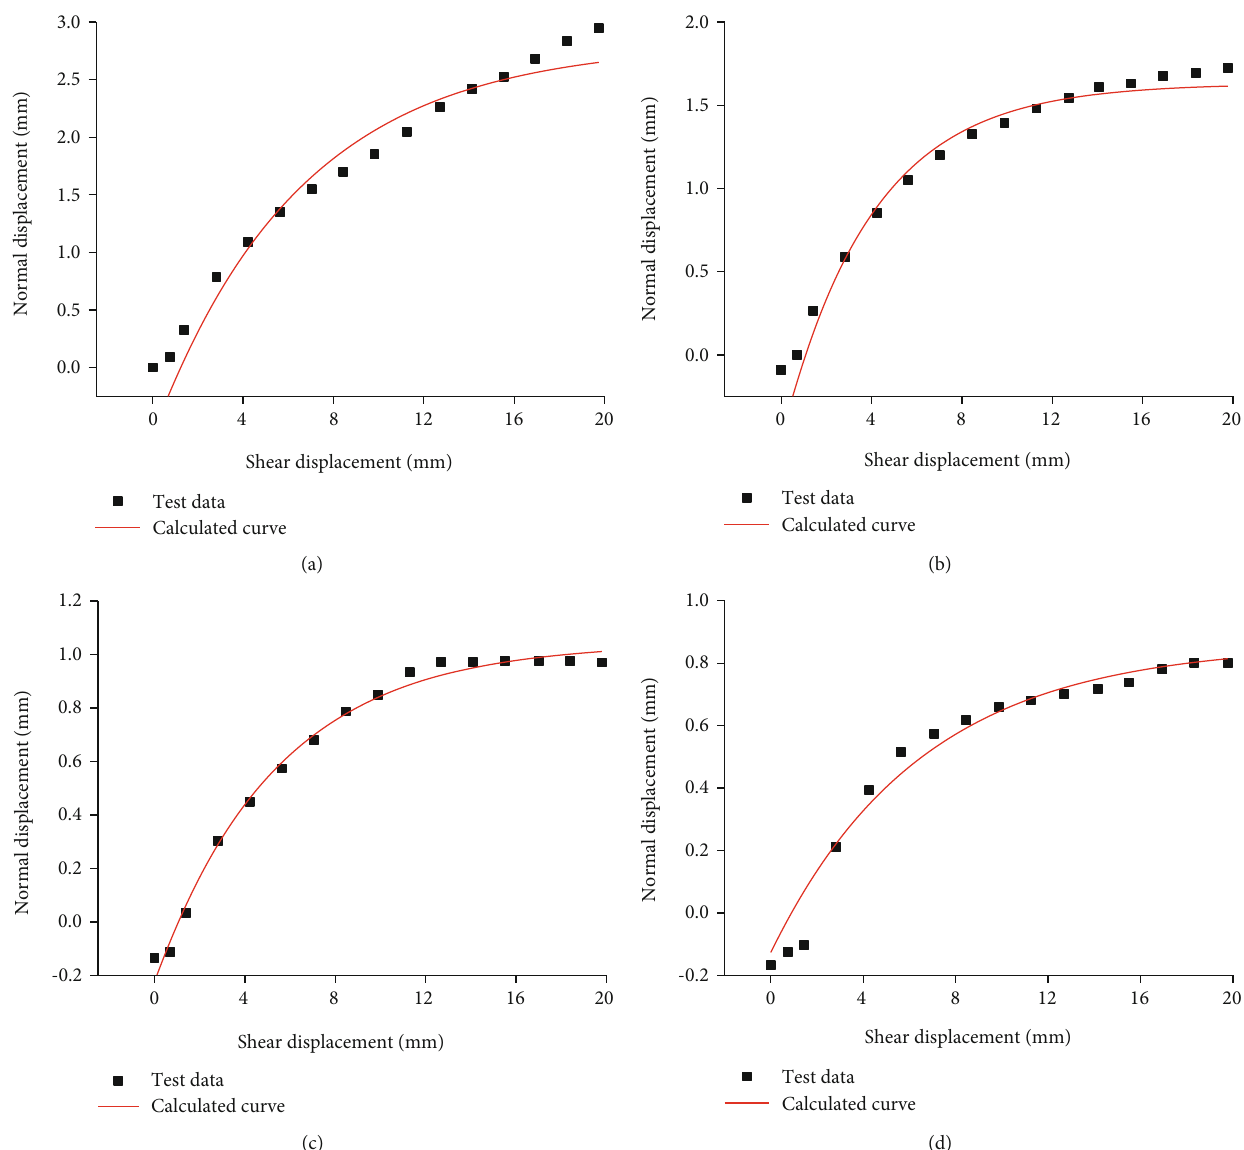
Figure 6: Comparisons between the observed curves (from Ref. [44]) and theoretical results from Eq. (27): (a) normal stress 1MPa; (b) normal stress 5MPa; (c) normal stress 10MPa; and (d) normal stress 20